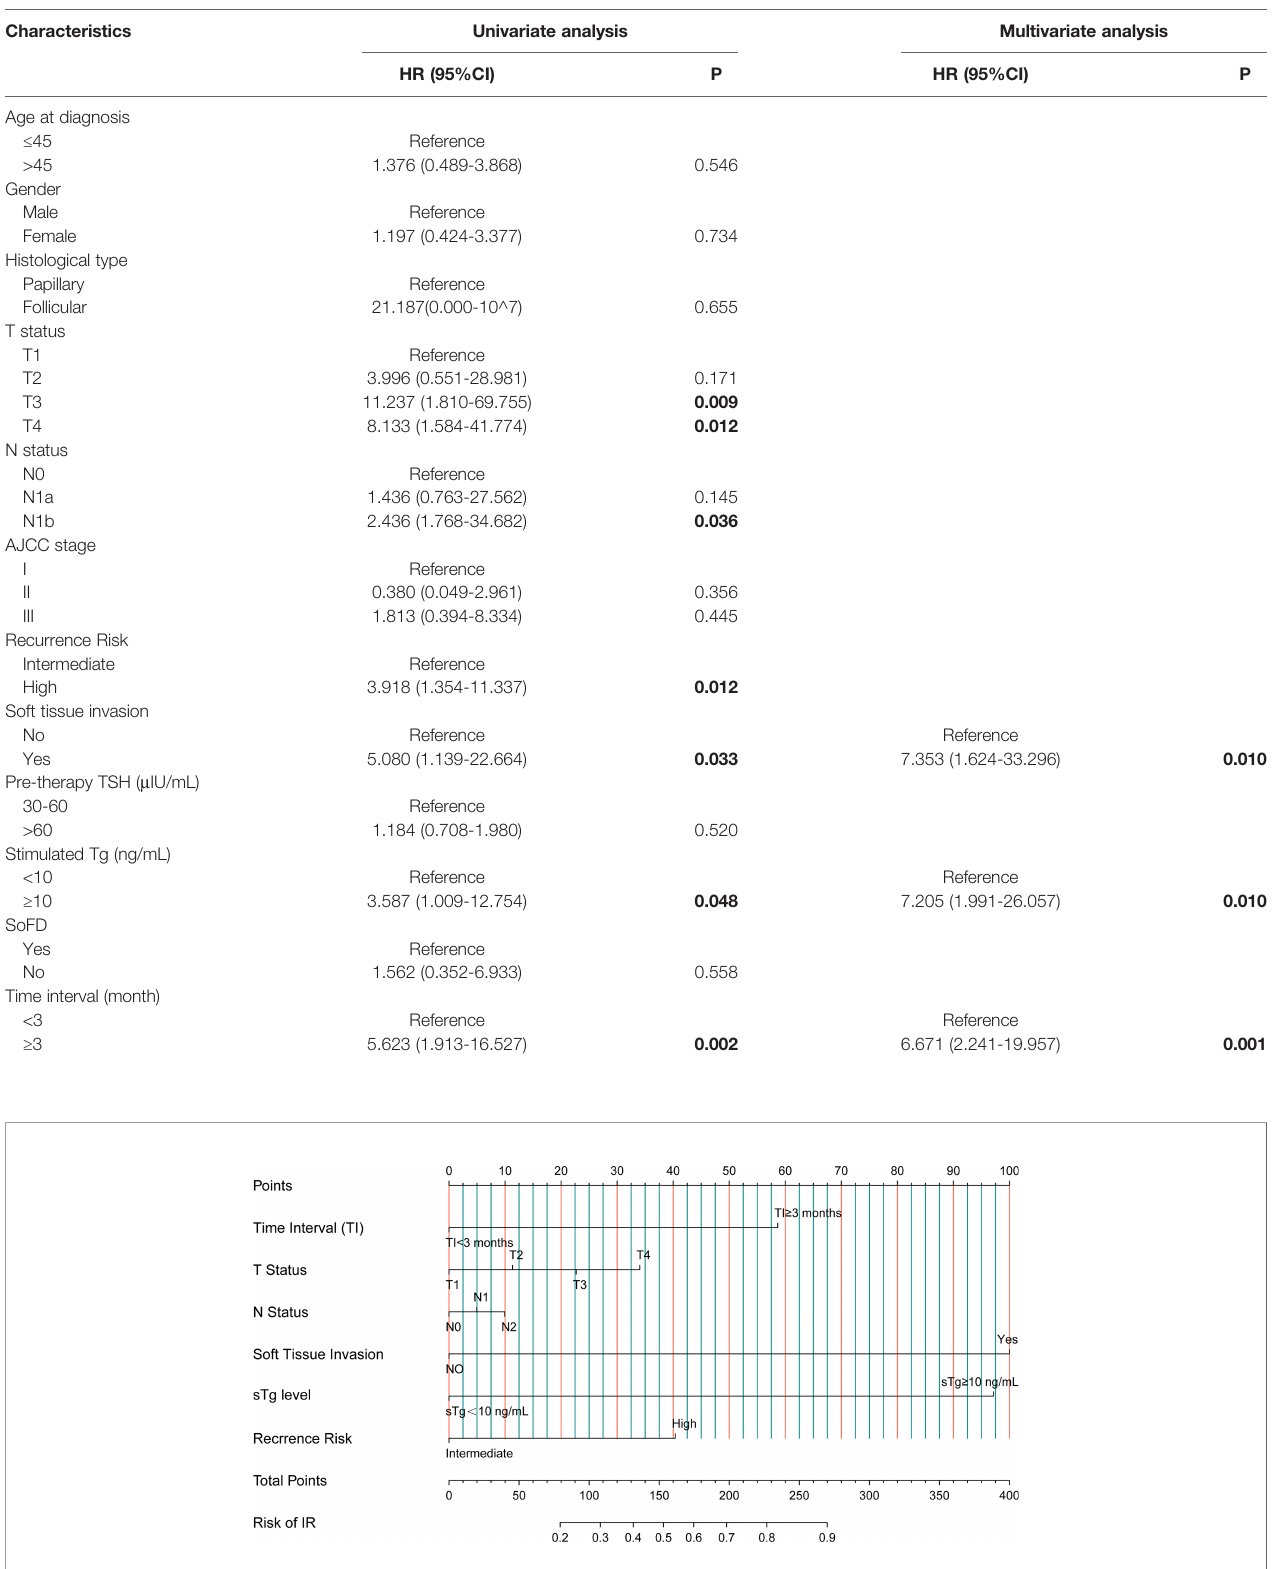
TABLE 4 | Univariate and multivariate Cox regression analysis based on all variables for IR.